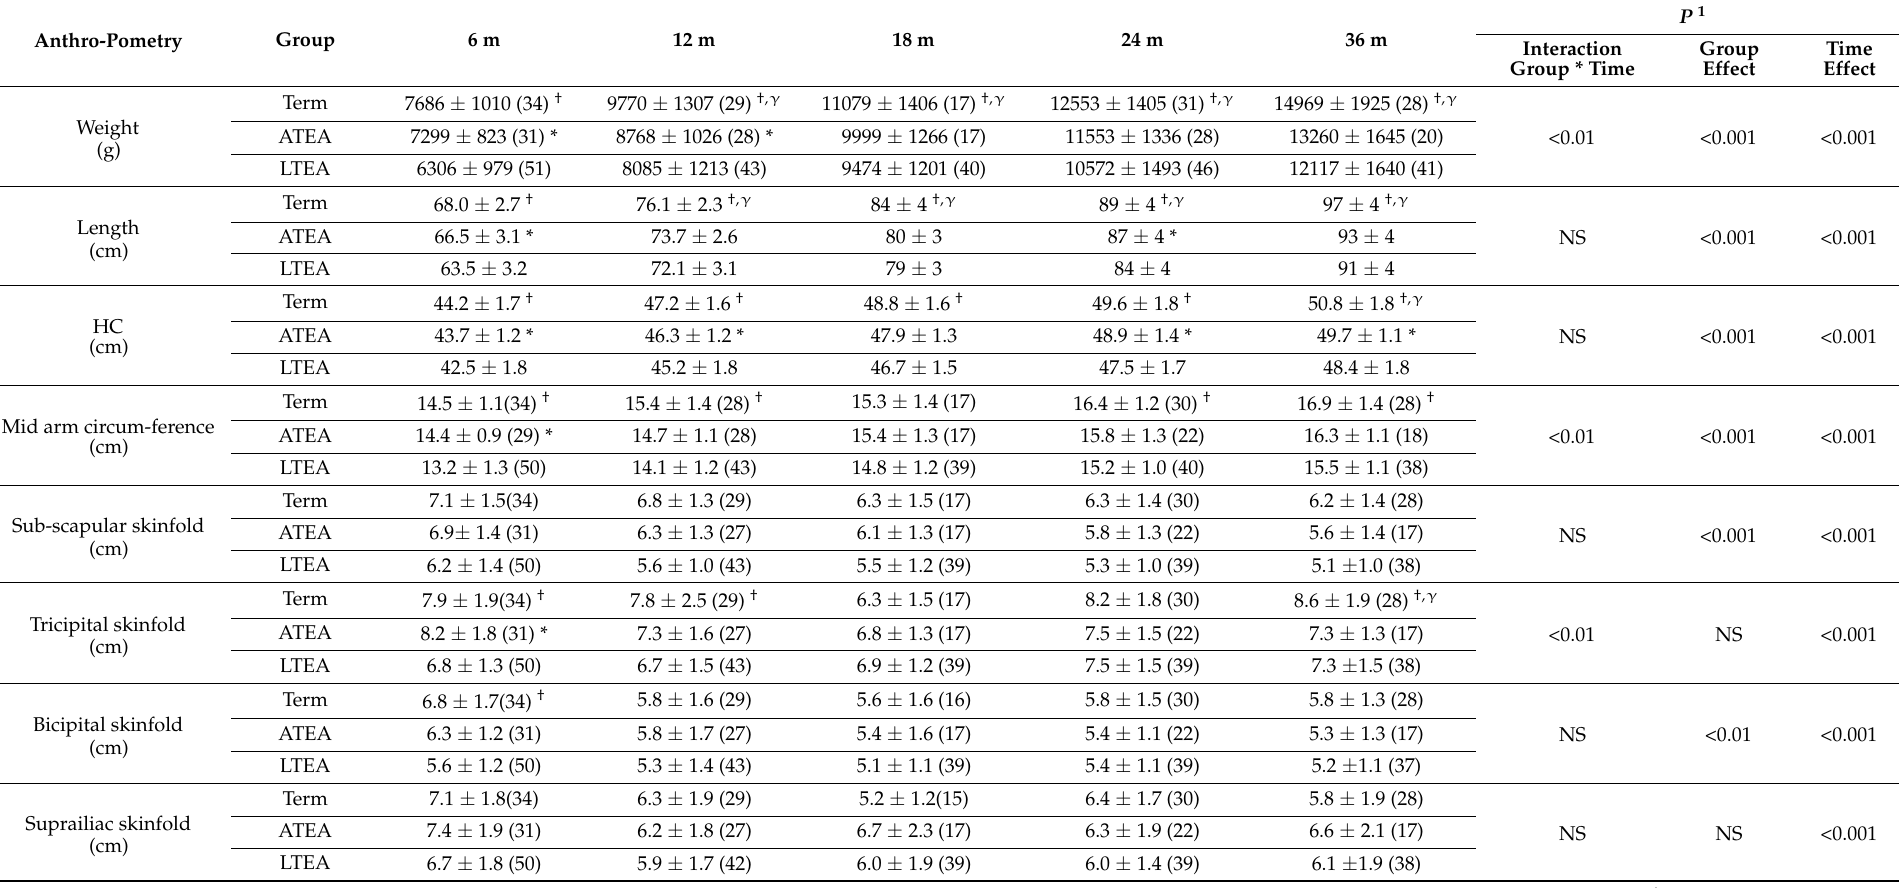
Table 3. Anthropometric measurements during the first three years of